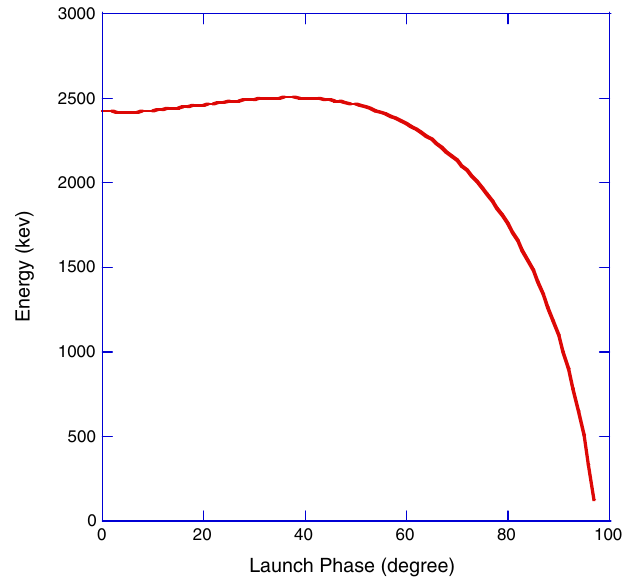
FIG. 4. Dependence of electron energy on rf phase of the injector cavity.